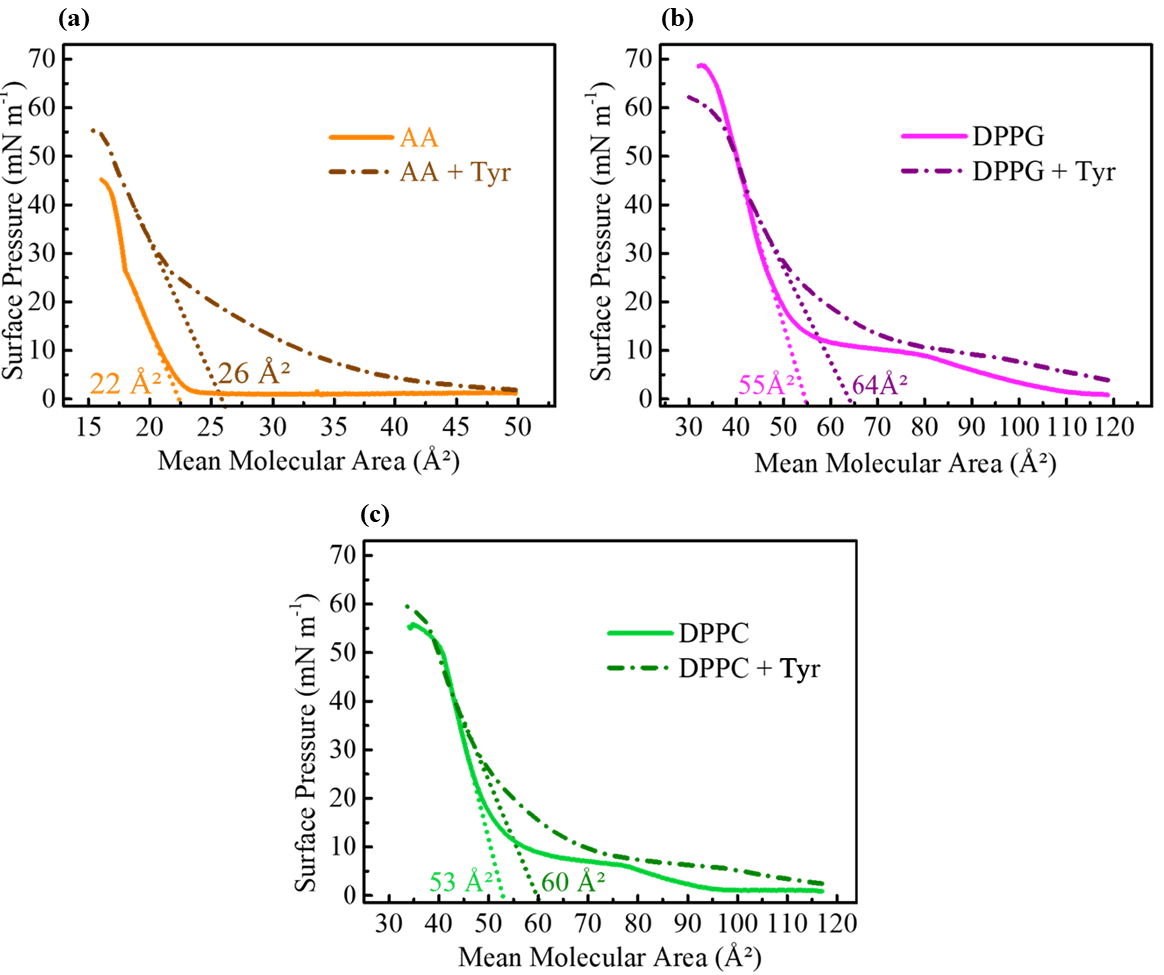
Figure 2. π-A isotherms for Langmuir monolayers of AA ( a ), DPPG ( b ), and DPPC ( c ) at the air/water interface for PBS subphase in absence and presence of Tyr (1.74 mg mL -1